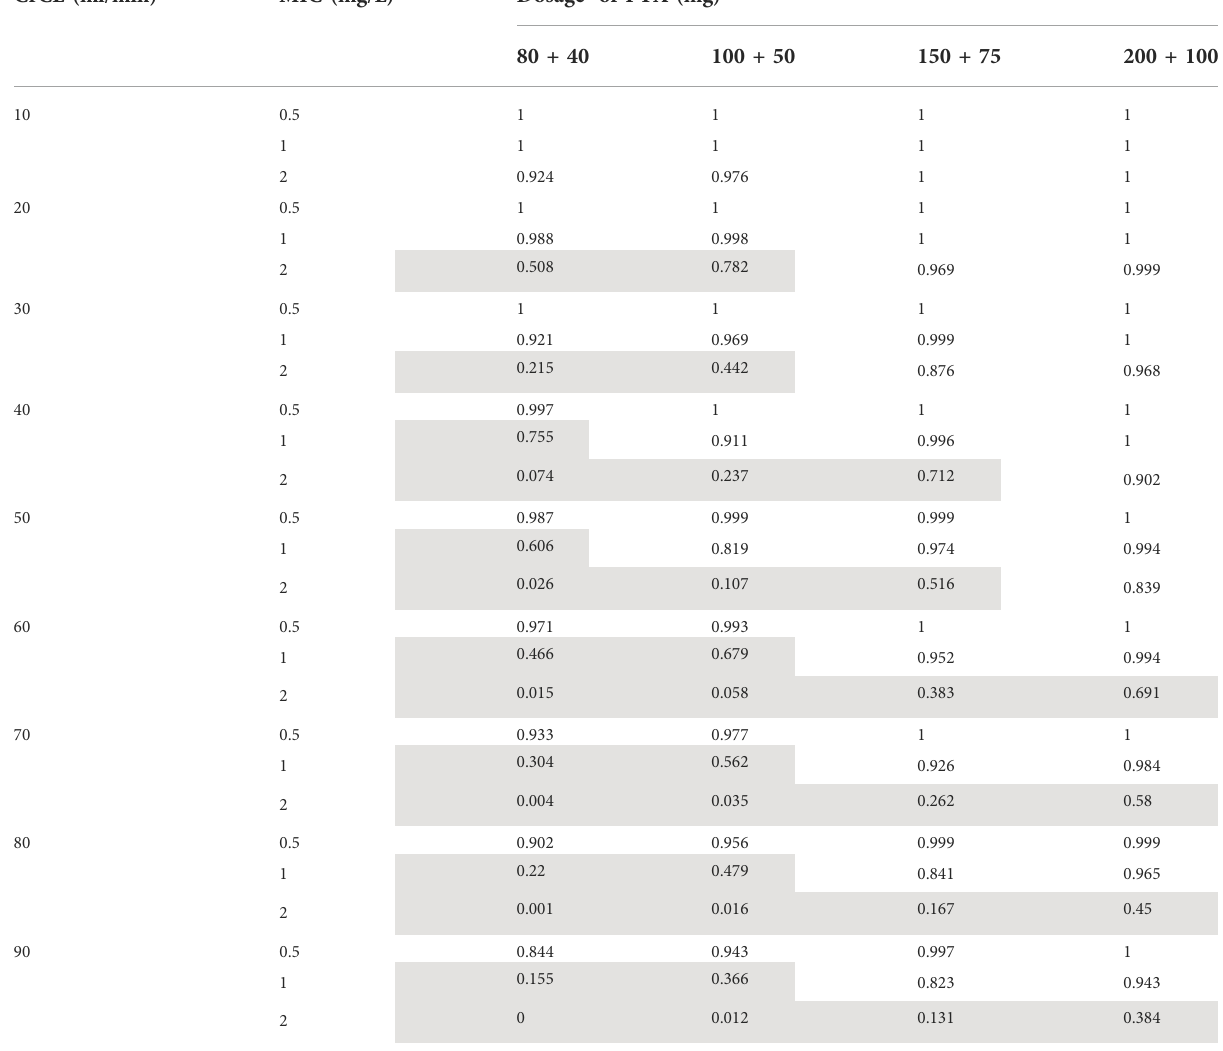
TABLE 4 Probability of target attainment based on different CrCL and dosage regimens. CrCL